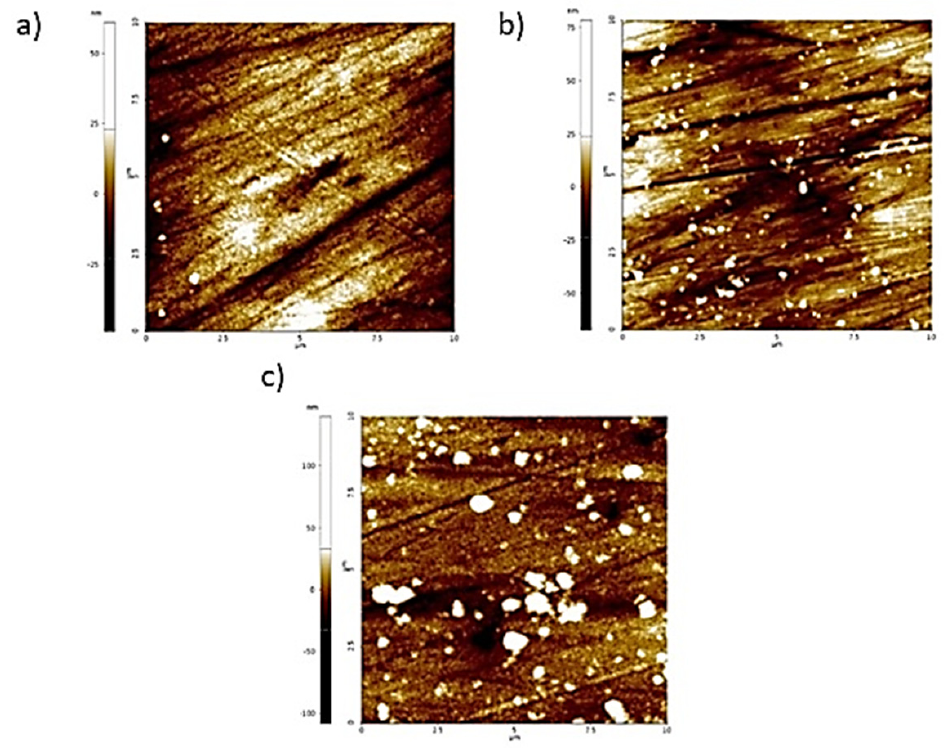
Figure 2. AFM surface topography images of the ZnO thin film deposited after ( a ) 500, ( b ) 1000, and ( c ) 1500 cycles.